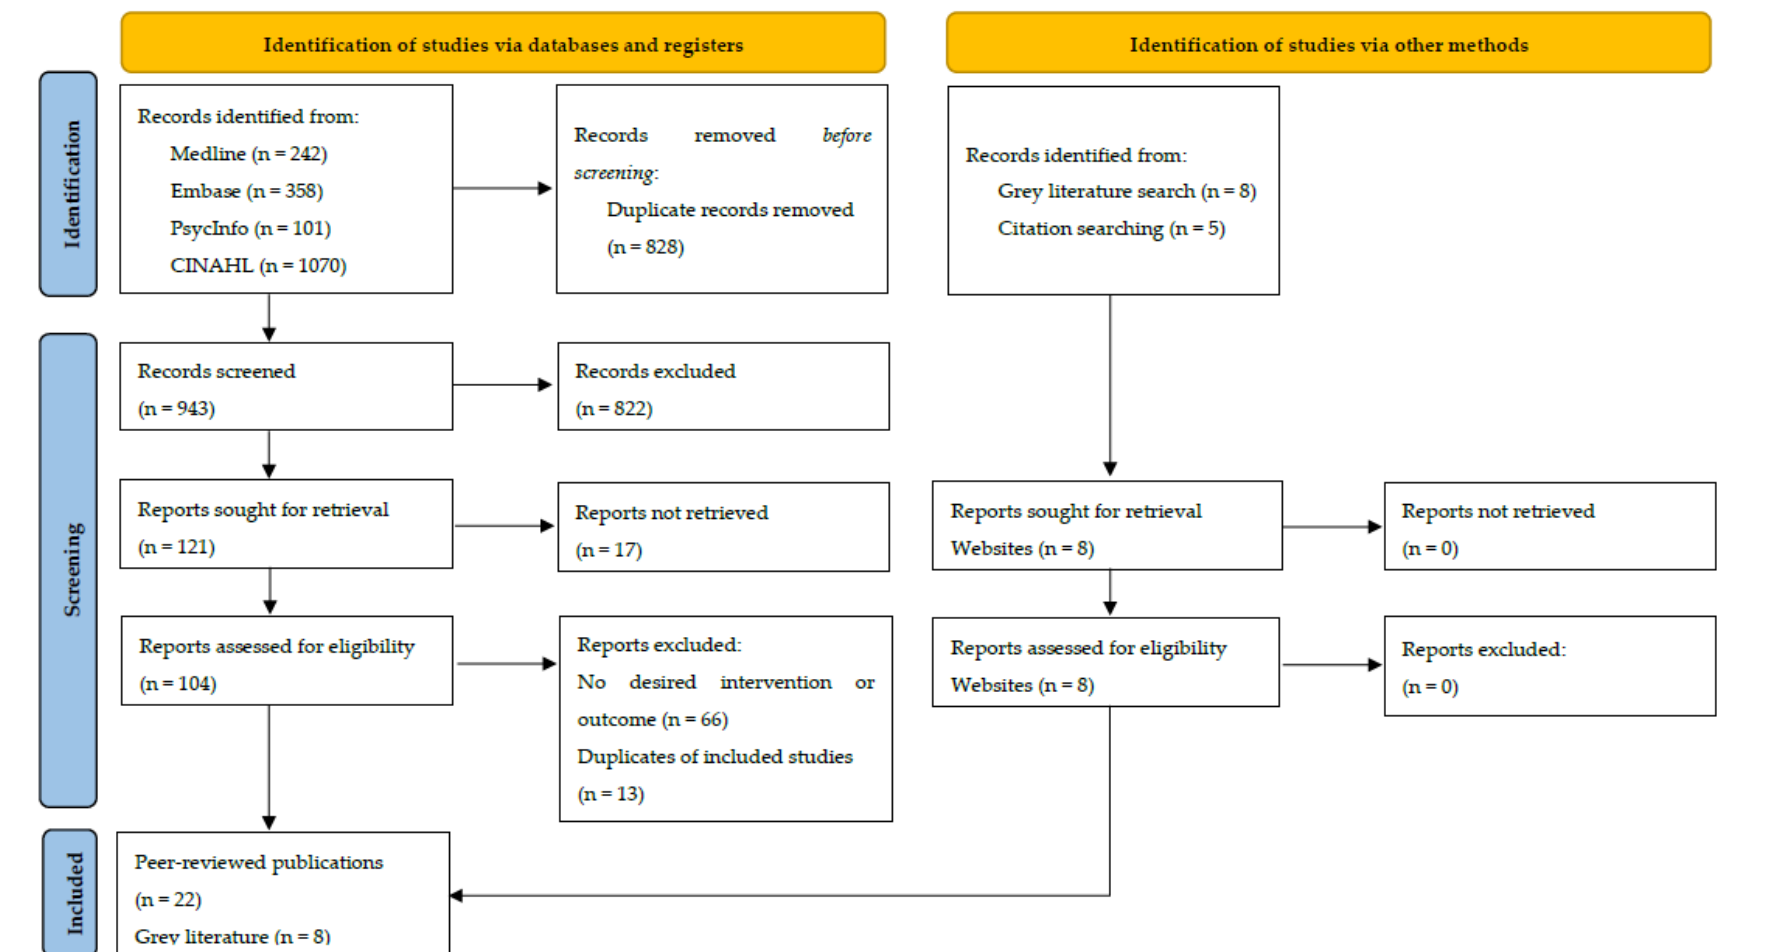
Figure 1. Preferred Reporting Items for Systematic Reviews and Meta-Analyses for the scoping review process (PRISMAScR) flow diagram.